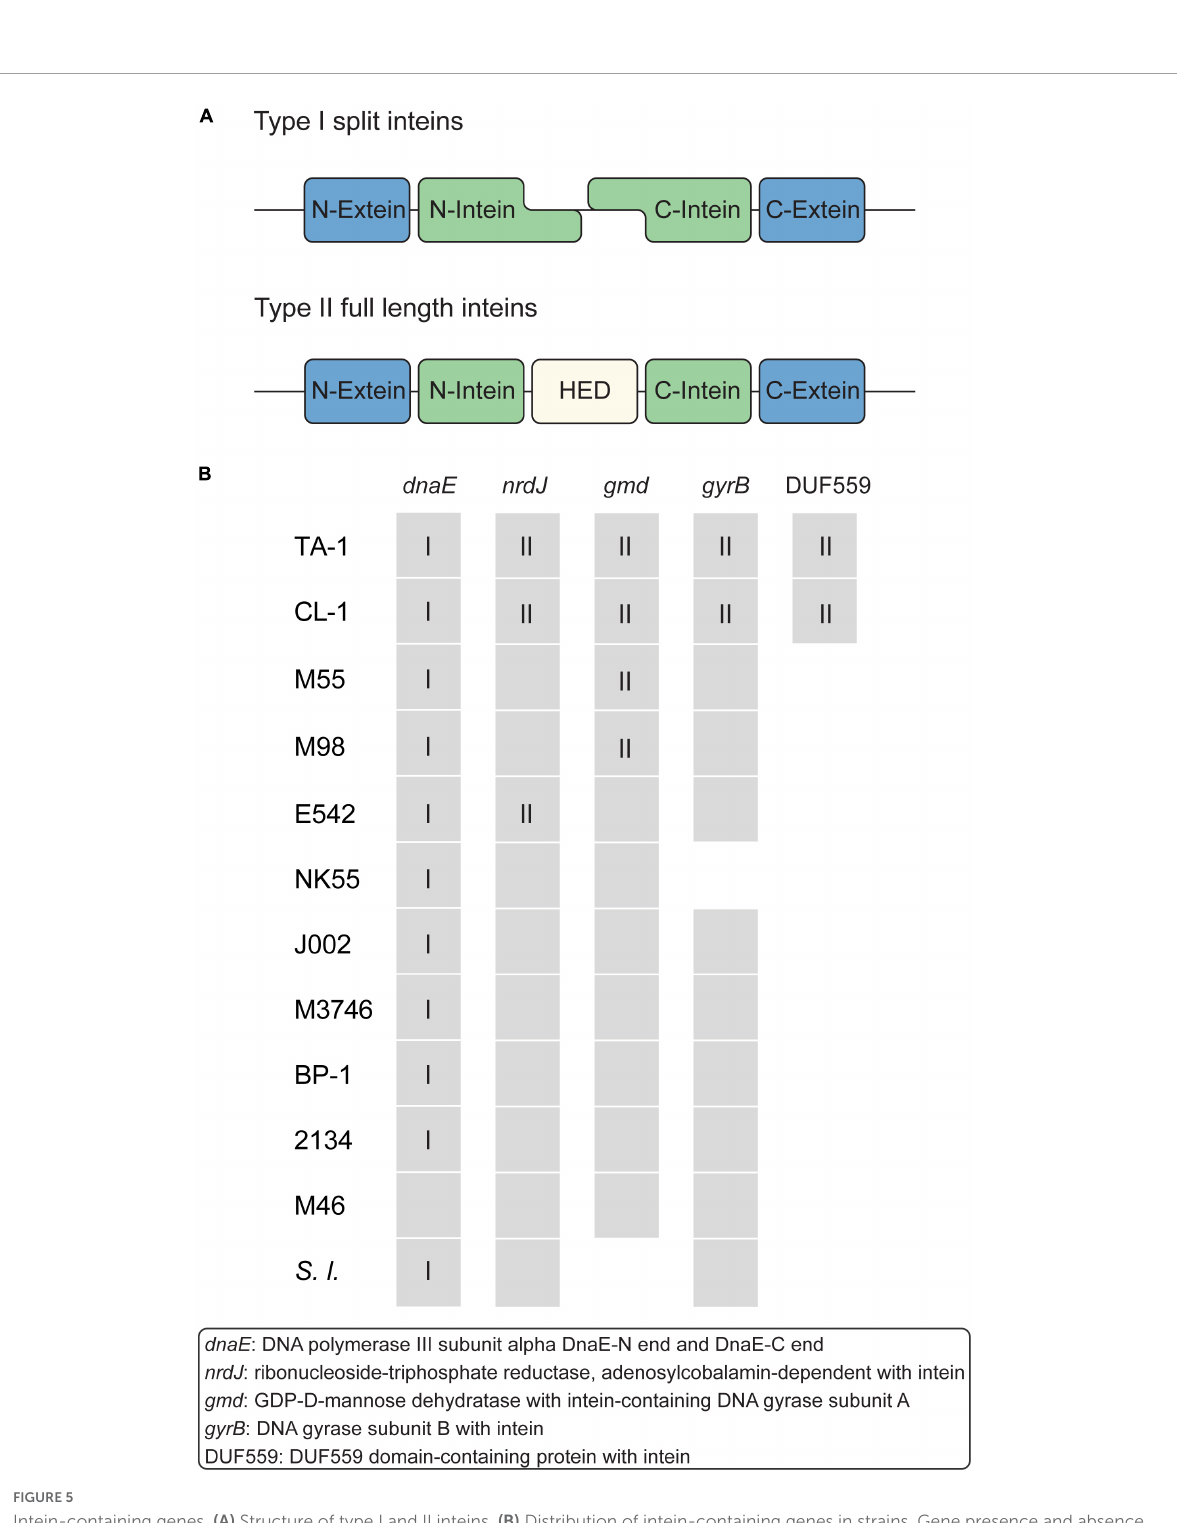
function in the mobilization and propagation of inteins (Nanda et al., 2020). Type III mini-inteins have a contiguous protein splicing domain but lack a